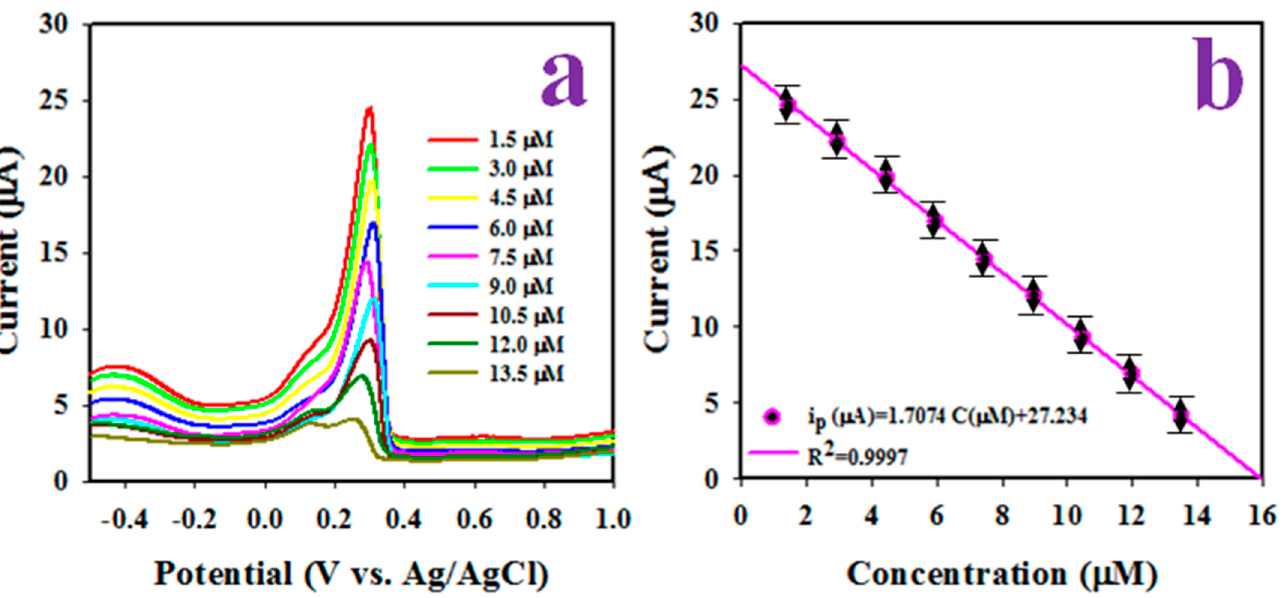
Figure 8. Detection of target analyte with Ag-decorated Chitosan/SrSnO 3 NC/GCE. ( a ) Resulting DPV analysis of 2,6-DNP at 7.0 pH buffer and ( b ) Calibration of 2,6-DNP sensor obtained from current versus concentration of 2,6-DNP.